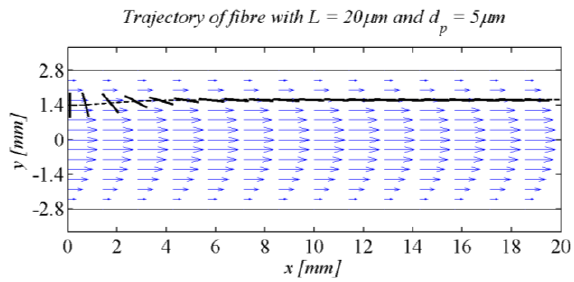
Fig. 8. Trajectory and orientation of fibre with L=20 µm and d p =5 µm if the dumping term is included